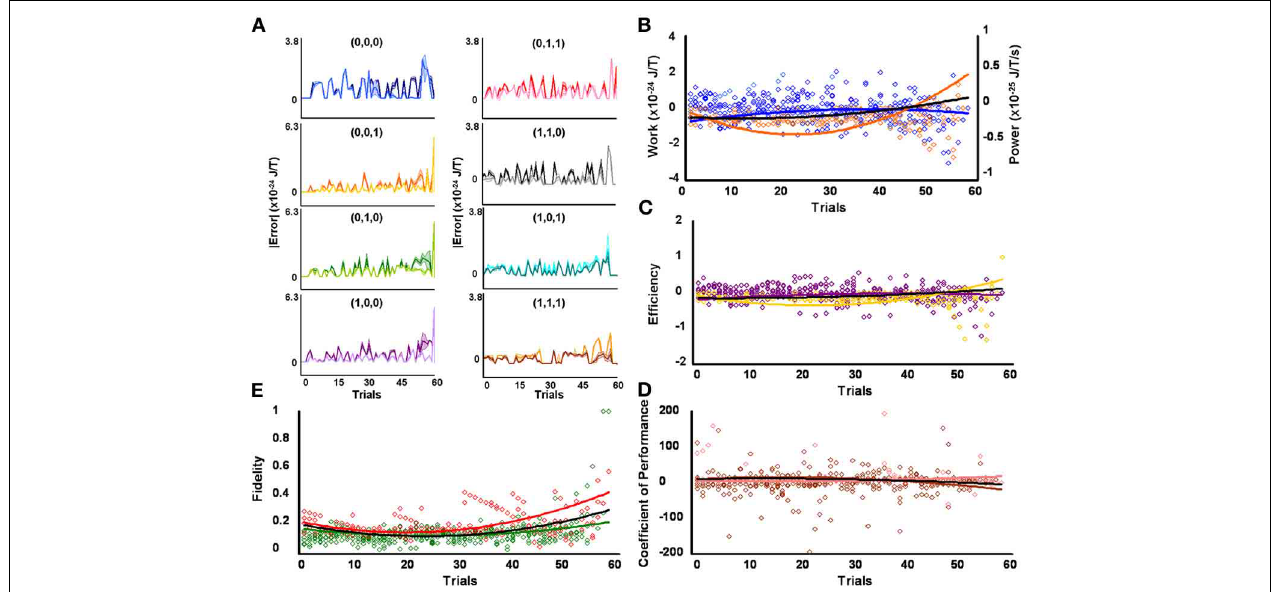
FIGURE 4 | Initial high responders learn to diagnose and correct classical errors in executed contraction strategies signaling mating fitness. (A) Repetition coding prevented errors in executed serial contraction signals from exceeding estimated single bit-flip errors in absolute mean average Boltzmann entropy [executed (light blue) and bit-flipped (dark blue) strategy (0,0,0), executed (light orange) and bit-flipped (dark orange) strategy (0,0,1),